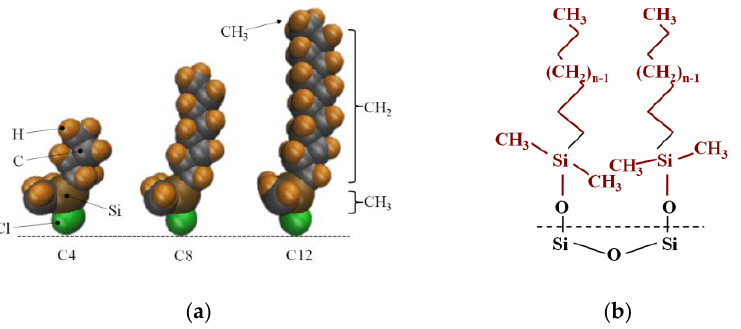
Figure 1. The process diagram of modified silica gel. ( a ) Alkyl chlorosilane molecule; ( b ) the molecular structure of the nanochannel wall after